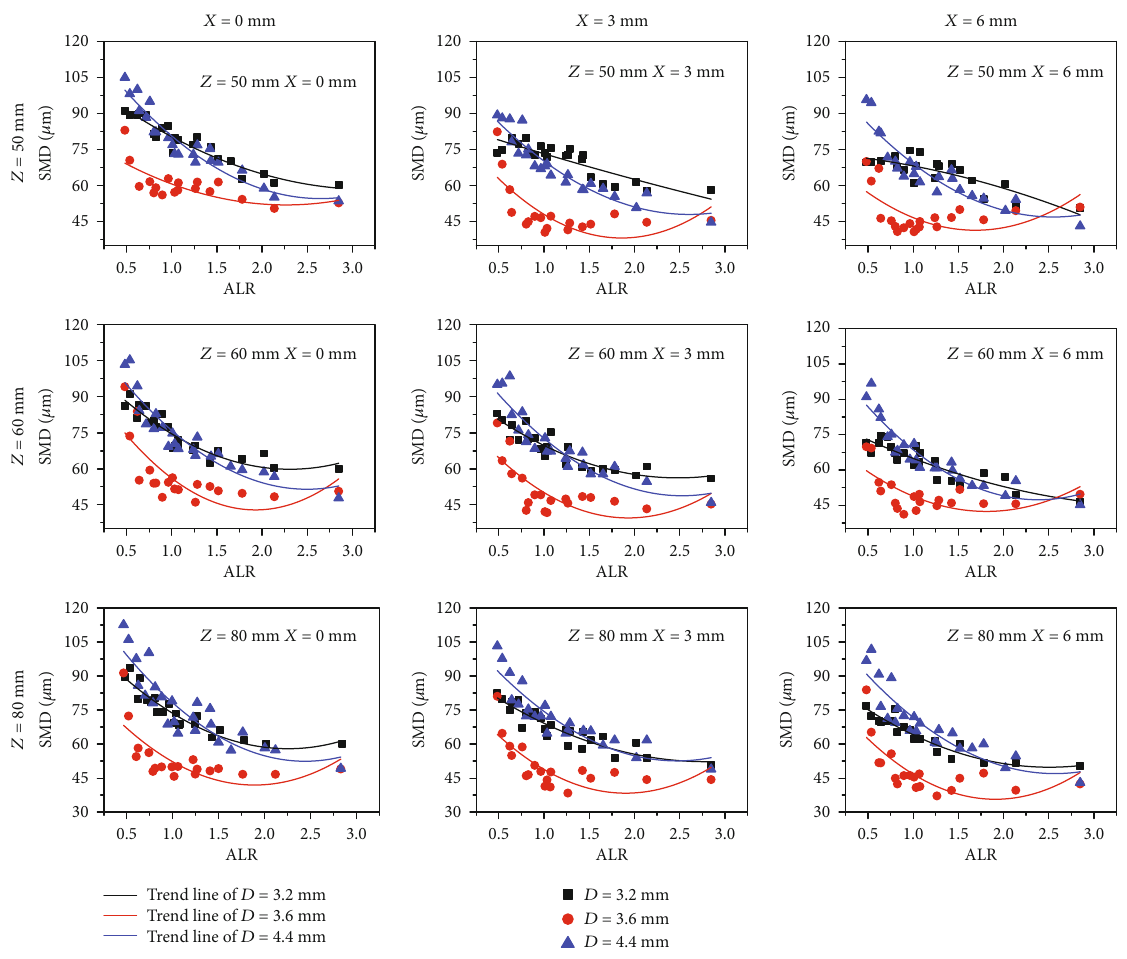
Figure 13: Comparison of SMD characteristics of D series nozzle at various downstream axial distances.